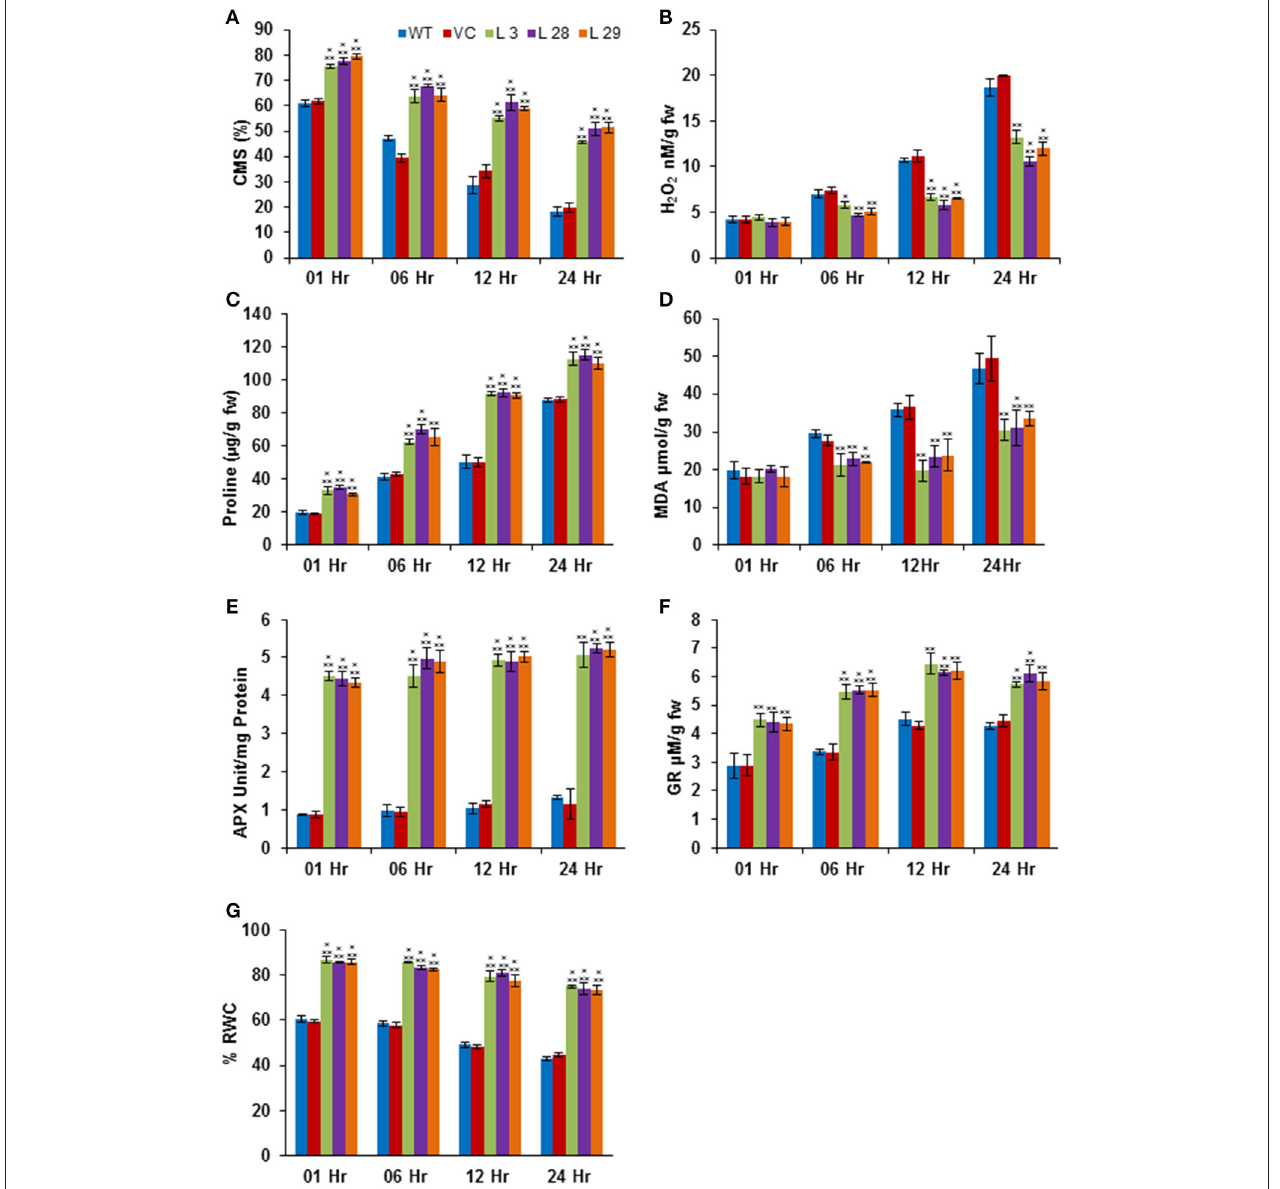
FIGURE 6 | Biochemical and physiological responses of SbSLSP transgenic plants, and VC and WT under drought stress (20% PEG). (A) Percentage of cell membrane stability. (B) Changes in hydrogen peroxide content. (C) Changes in the level of proline accumulation. (D) Levels of lipid peroxidation expressed in terms of MDA content. (E) Changes in ascorbate peroxidase enzyme activity. (F) Changes in glutathione reductase enzyme activity. (G) Percentage of relative water content. One-way analysis of variance (ANOVA) was used to test the significance between the mean values of control and transgenic plants, and comparison among mean values was performed using ezANOVA (http://www.cabiatl.com/mricro/ezanova/). The difference between control and transgenic lines were statistically significant at * P < 0.05, ** P < 0.01 and *** P <